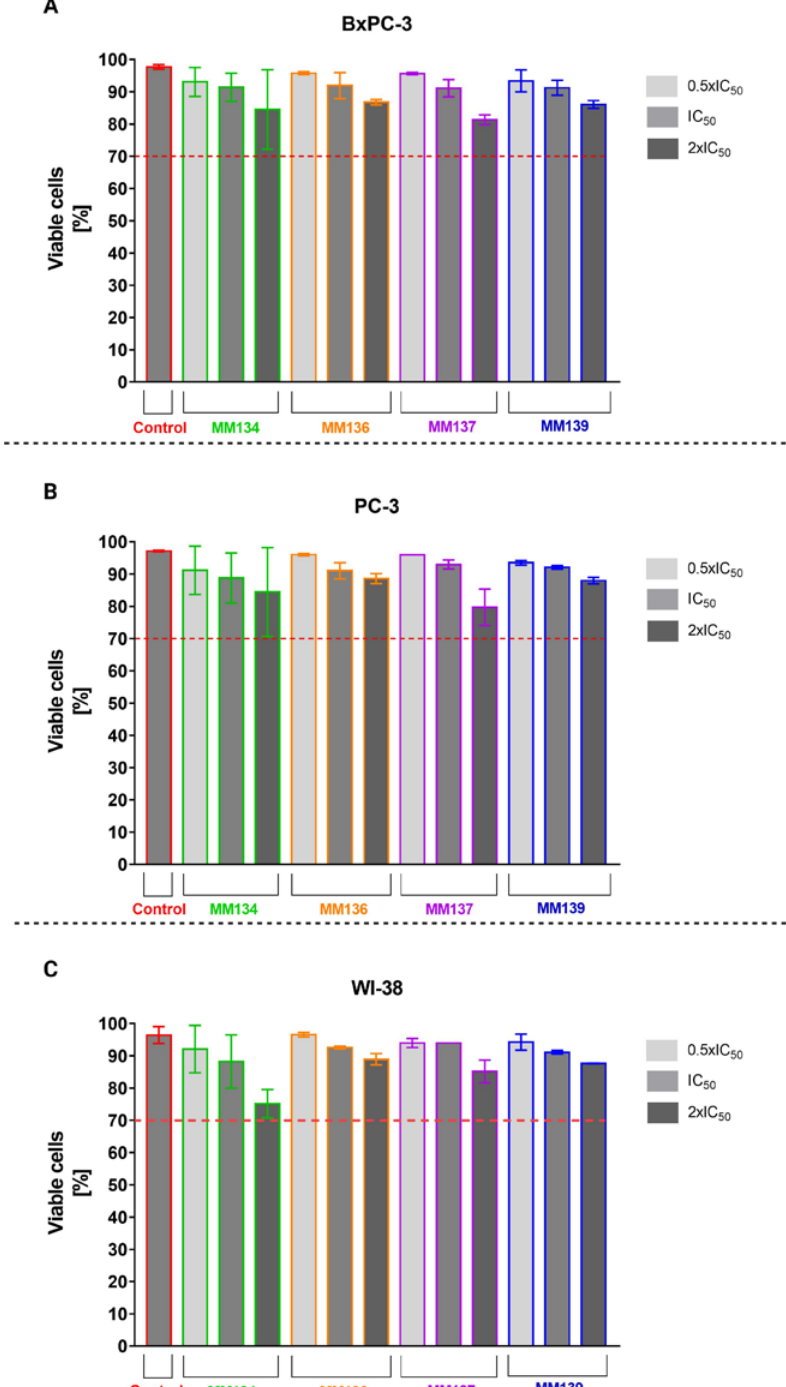
Figure 3. Trypan blue staining: effect of MM134 , -6 , -7 , and -9 used in concentrations of 0.5 (light gray), 1 (gray), and 2 (dark gray) times IC 50 values on cancer cell (BxPC-3 ( A ) and PC-3 ( B )) and normal human fibroblast (WI-38) ( C ) cell viability measured with trypan blue staining assay. Cells were exposed to tested compounds for 24 h at 37 ◦ C. The mean values were obtained from three independent experiments. ± SD